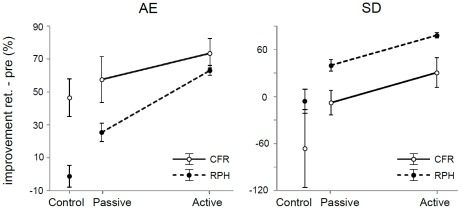
Improvement from Pre-test to Retention.Improvement (in percentage), i.e., inverse of error decrease, of Retention compared to Pre-test under feedback per group for AE (left) and SD (right). Filled dots & striped lines: improvements on relative phase (RPH); Open dots & solid lines: improvements on relative cycling frequency ratio (CFR).